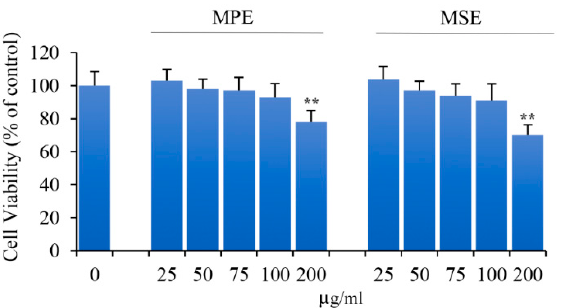
Figure 2. Effects of MPE and MSE on the viability of 3T3-L1 pre-adipocyte cells. 3T3-L1 cells (8 × 10 3 /200 µL of culture medium) were exposed to different doses (25–200 µg/mL) of MPE or MSE for 8 days. Then, the percentage of viable cells was assessed by MTT assay. The values reported are the mean ± SD of three independent experiments. ** p < 0.01 with respect to control cells treated with vehicle only.